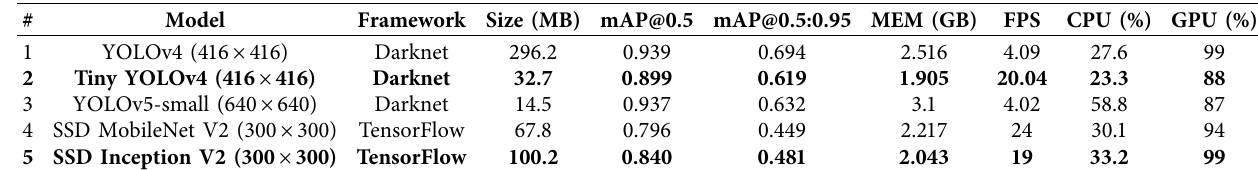
Table 2: Experimental results about running models on Jetson